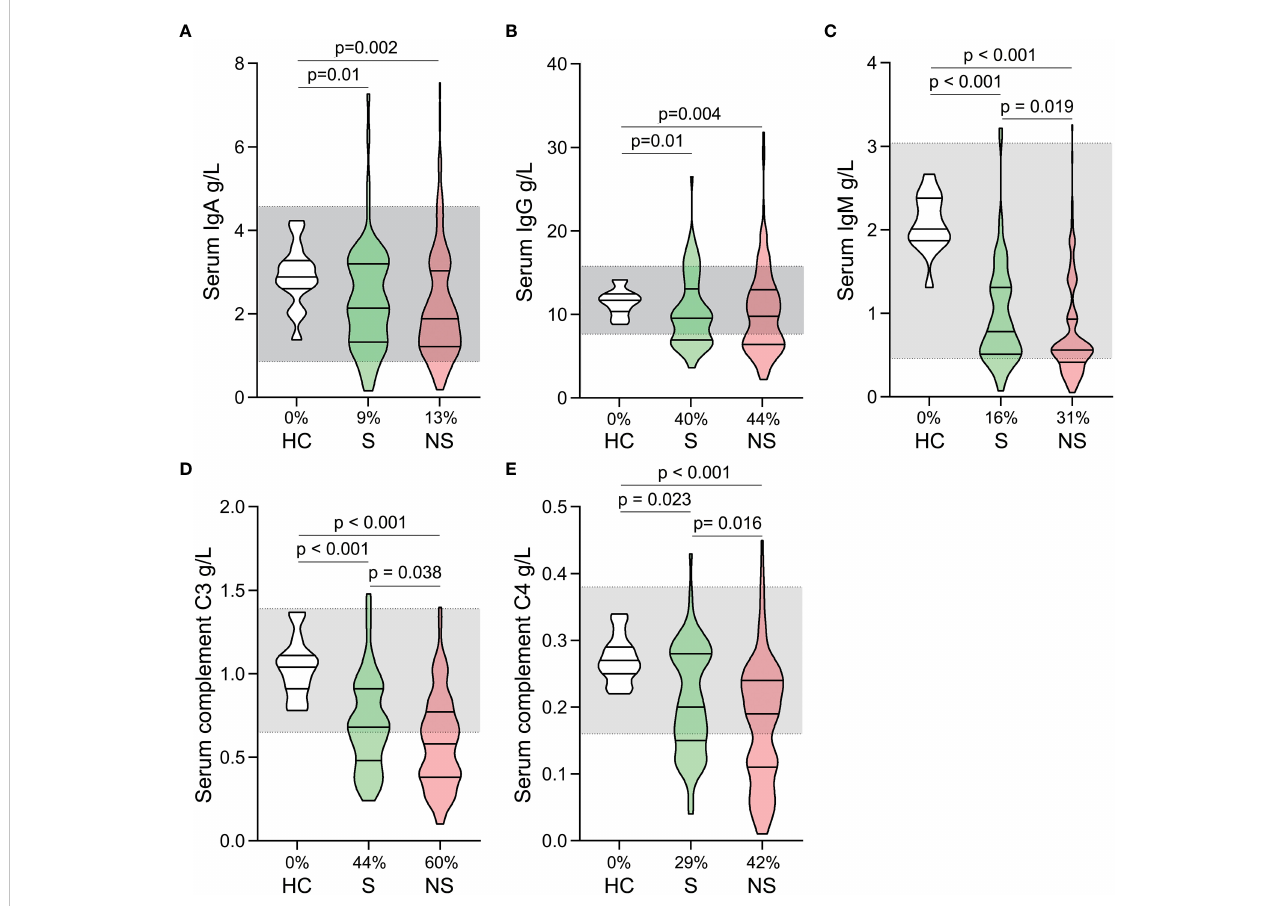
FIGURE 3 Fluctuations of serum immunoglobulin and complement levels in patients with septic shock. The levels of IgA (A) , IgG (B) , IgM (C) , C3 (D) , and C4 (E) were compared among healthy controls, survivors, and nonsurvivors. The shaded region represents the normal value range. The proportions of patients whose test results are below the lower limit of the normal range are shown on the x-axis (A – E)